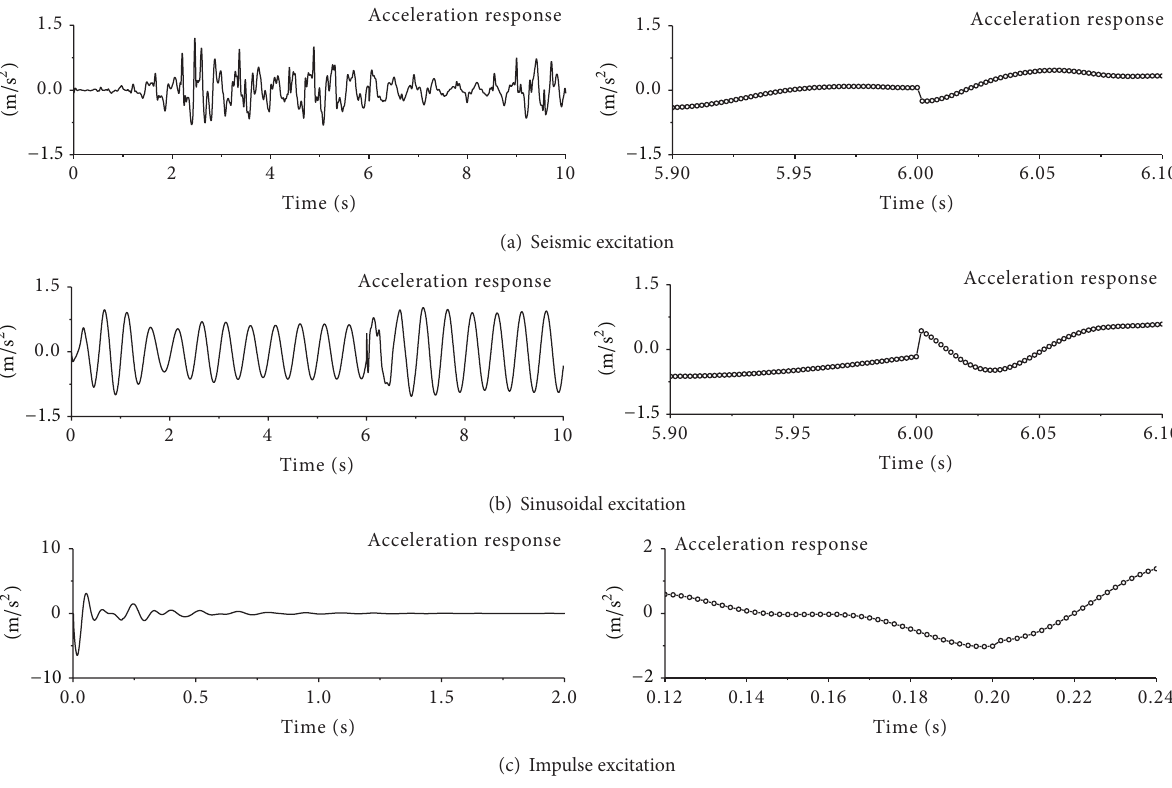
Figure 2: Signal discontinuity due to sudden